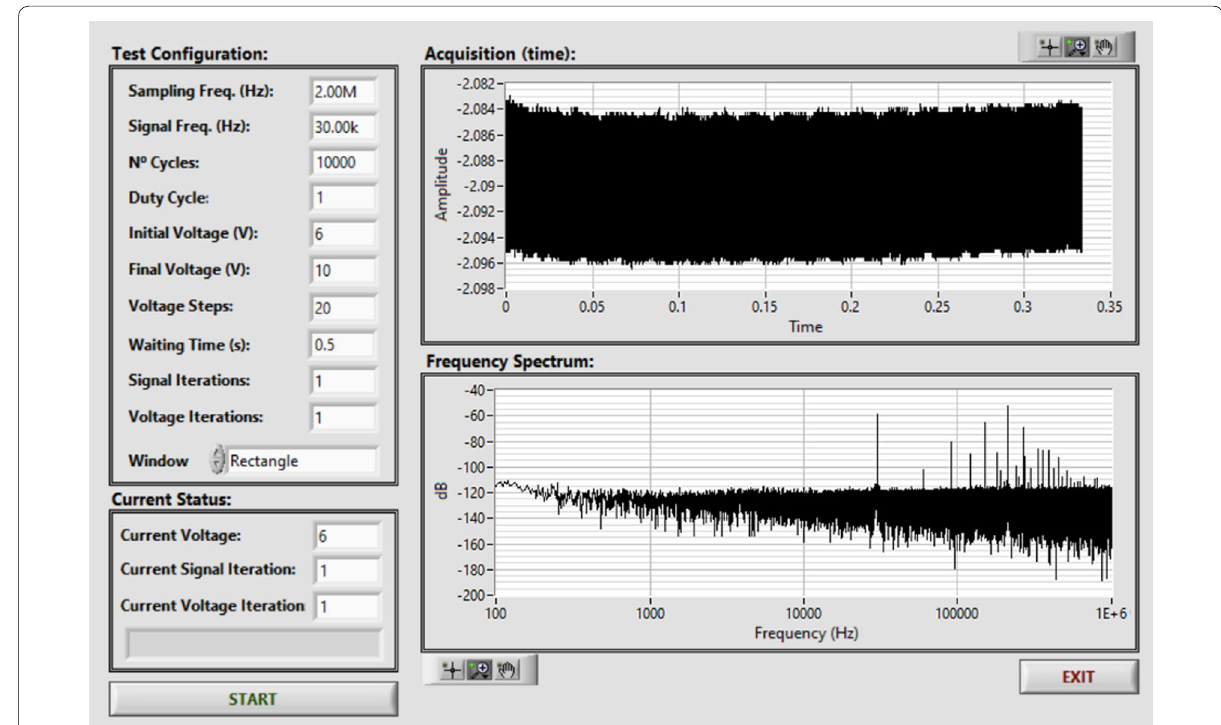
Fig. 6 Emission and signal acquisition application front